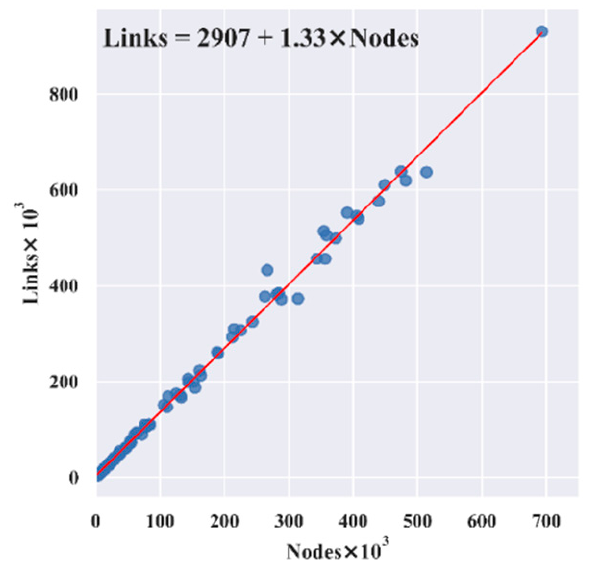
Figure 2. Linear relationship between links and Figure 3. Linear relationship between links and nodes.